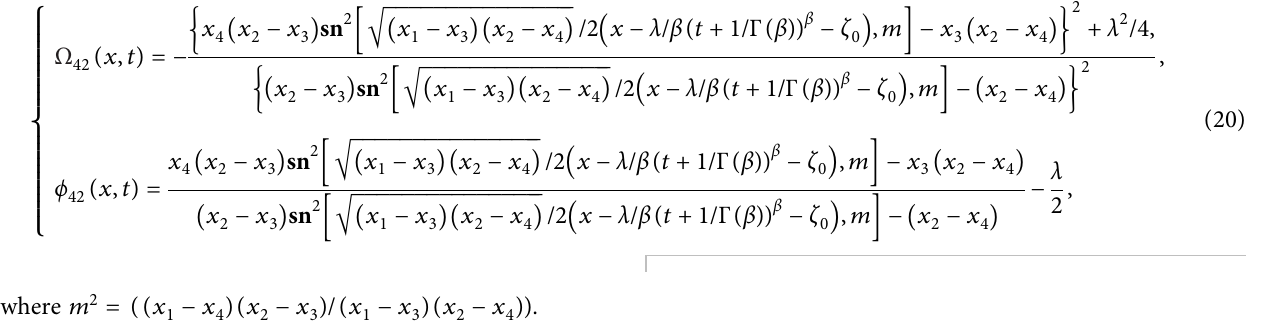
Figure 2: Te graphics of Ω plot (d) Contour